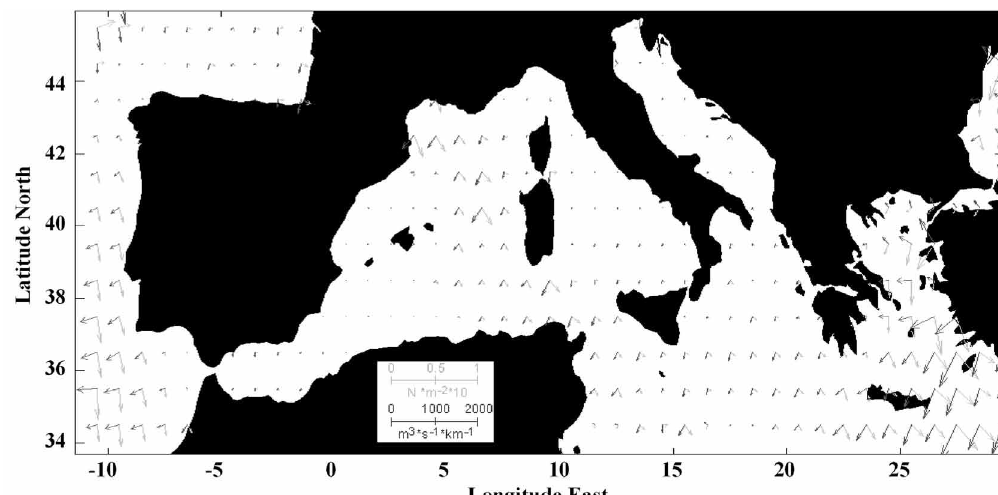
Fig . 3. – Resultant vectors of Qx and Qy Ekman transport (dark grey arrows) and τ Mediterranean Sea and near North Atlantic Ocean. Vectors represent the climatological averages of COADS monthly summaries covering